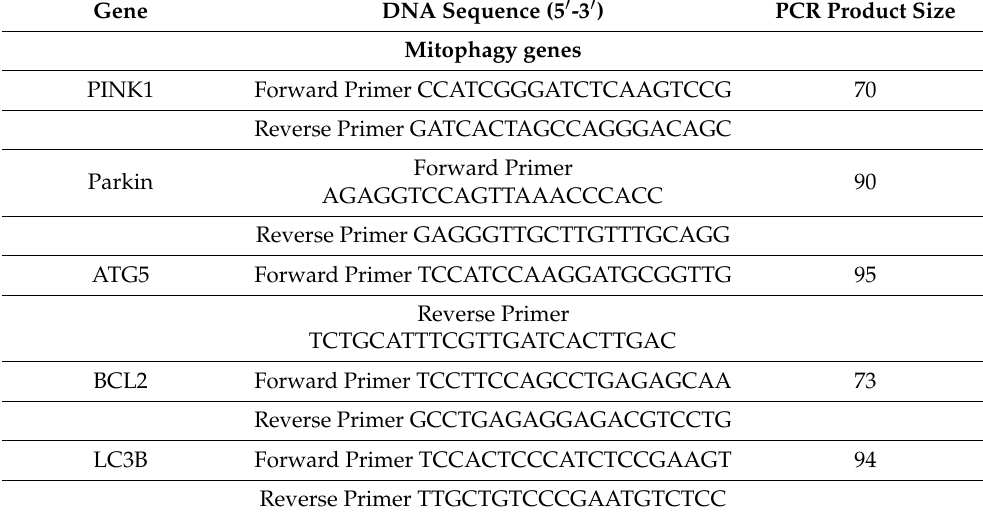
Table 1. Cont. Gene DNA Sequence (5 (cid:48) -3 (cid:48) )